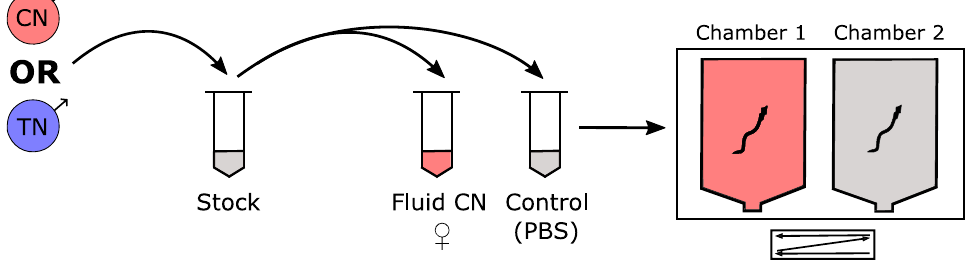
Figure 5. Design of the experiment comparing velocity of conspecific and heterospecific sperm in the fluid from the female reproductive tract. Velocity of conspecific and heterospecific sperm was measured in the common nightingale (CN) female fluid and directly compared with the velocity in the control environment (physiological saline buffer, PBS) using one microscopic slide with two chambers. TN, thrush nightingale; CN, common nightingale.